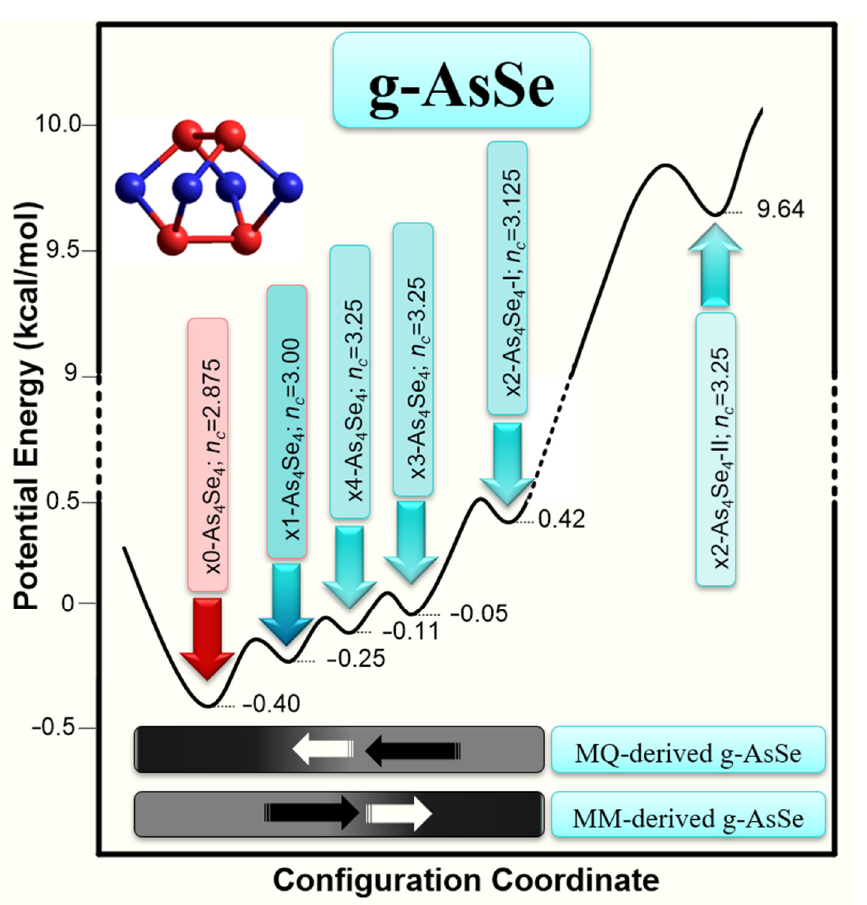
Figure 4. Potential energy landscape showing diversity of molecular-network cluster-related states in arsenic monoselenide g-AsSe. The cluster-forming energies E f (in kcal/mol) of As 4 Se 4 cage-like molecule x0-As 4 Se 4 and its network-forming derivatives are denoted below energy wells pointed out by respectively colored arrows (the atom-averaged number of topological constraints n c is given). The configuration coordinate domains corresponding to preferential stabilization of MQ-derived (unmilled) and MM-derived (milled) amorphous structures are black-shadowed below.